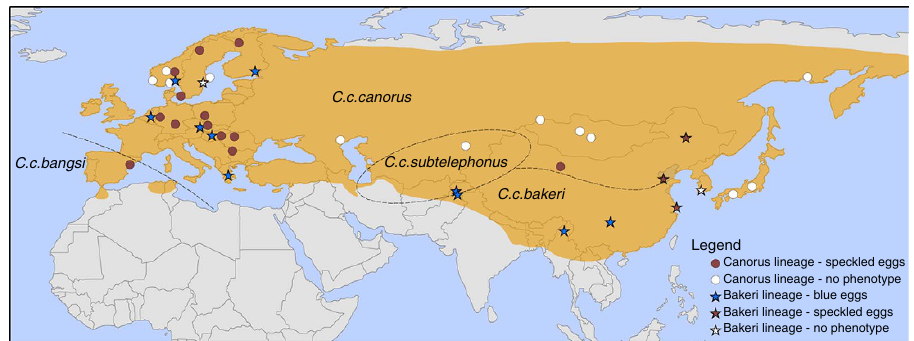
Figure 1 | DNA sampling. Breeding distribution (shaded) of the four common cuckoo Cuculus canorus subspecies 44 along with DNA sampling localities coded to illustrate the geographic distribution of two divergent mitochondrial lineages and their corresponding egg colours. All cuckoos laying blue eggs belong to the same ancient mitochondrial lineage (labelled above as ‘ bakeri ’ but also including C. c. canorus blue eggs) but are indistinguishable from other common cuckoos at nuclear loci. The blue egg colour is therefore maternally inherited. A recent split within C. c. bakeri is associated with a loss of blue egg colour in eastern Asia. The map is constructed in ArcMap